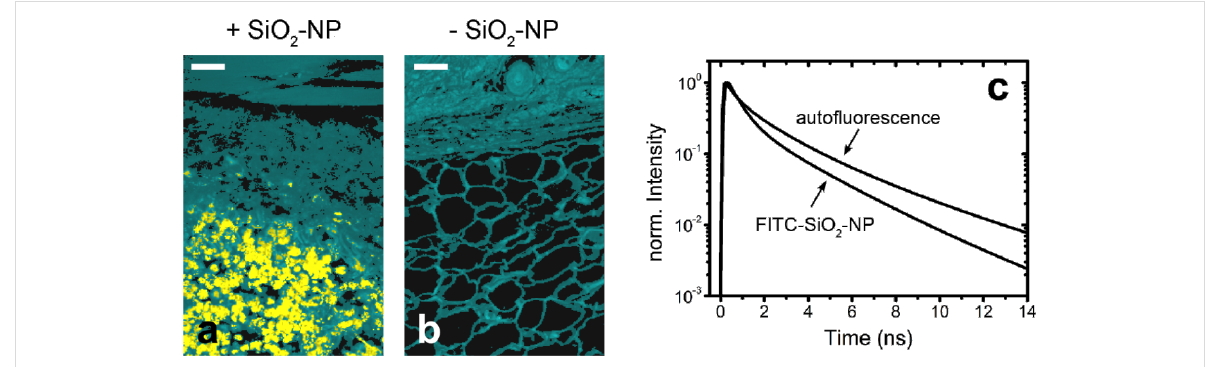
Figure 4: Discrimination of fluorescein isothiocyanate (FITC) labeled SiO 2 -NP (55 ± 6 nm in diameter) from the autofluorescent background of skin and subcutaneous tissue using fluorescence lifetime imaging microscopy (FLIM). False color coded sections of mouse skin including subcutis following subcutaneous particle injection from the site of injection (+SiO 2 -NP, (a)) and from the contralateral without NP (b) are presented. Cyan colored areas represent the autofluorescent background, while the yellow colored areas indicate a different lifetime species, which was identified as FITC-SiO 2 -NP. Scale bar = 50 µm. (c) Fluorescence lifetime curves of the tissue autofluorescence (mean lifetime curve) and of the FITC-SiO 2